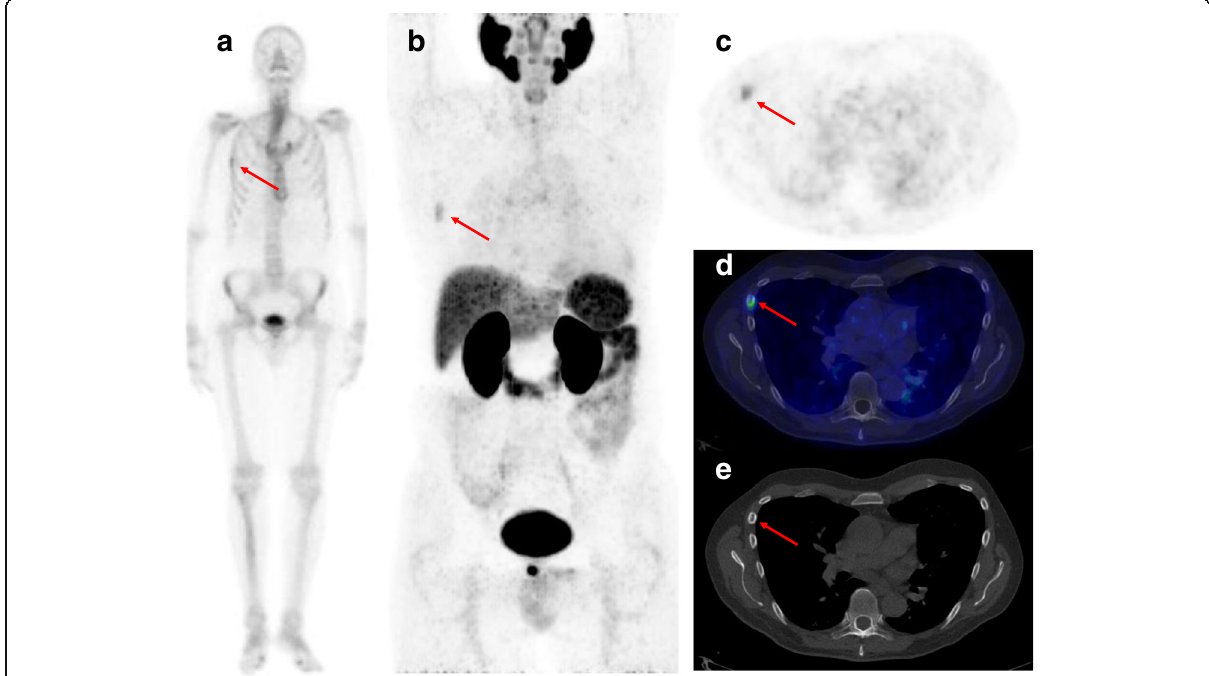
Fig. 3 Example of a patient (PSA 6 ng/mL, Gleason score 7, T2b) with four equivocal lesions according to BS (shown in anterior projection) ( a ) including a lesion in the fourth right rib indicated by the arrow. According to the 68 Ga-PSMA-11 PET/CT, the lesion was considered metastatic as shown by the 68 Ga-PSMA-11 MIP ( b ) with the corresponding axial 68 Ga-PSMA-11 PET ( c ), PET/CT fusion ( d ), and a slight sclerotic lesion in the axial CT image ( e ). Except for the high 68 Ga-PSMA-11 uptake in the prostate, no other suspicious lesions were observed. The patient underwent a CT- guided biopsy that showed benign findings, and then the patient had a radical prostatectomy without any systemic treatment. The PSA dropped to < 0.1 ng/mL after prostatectomy and remained so for at least 12